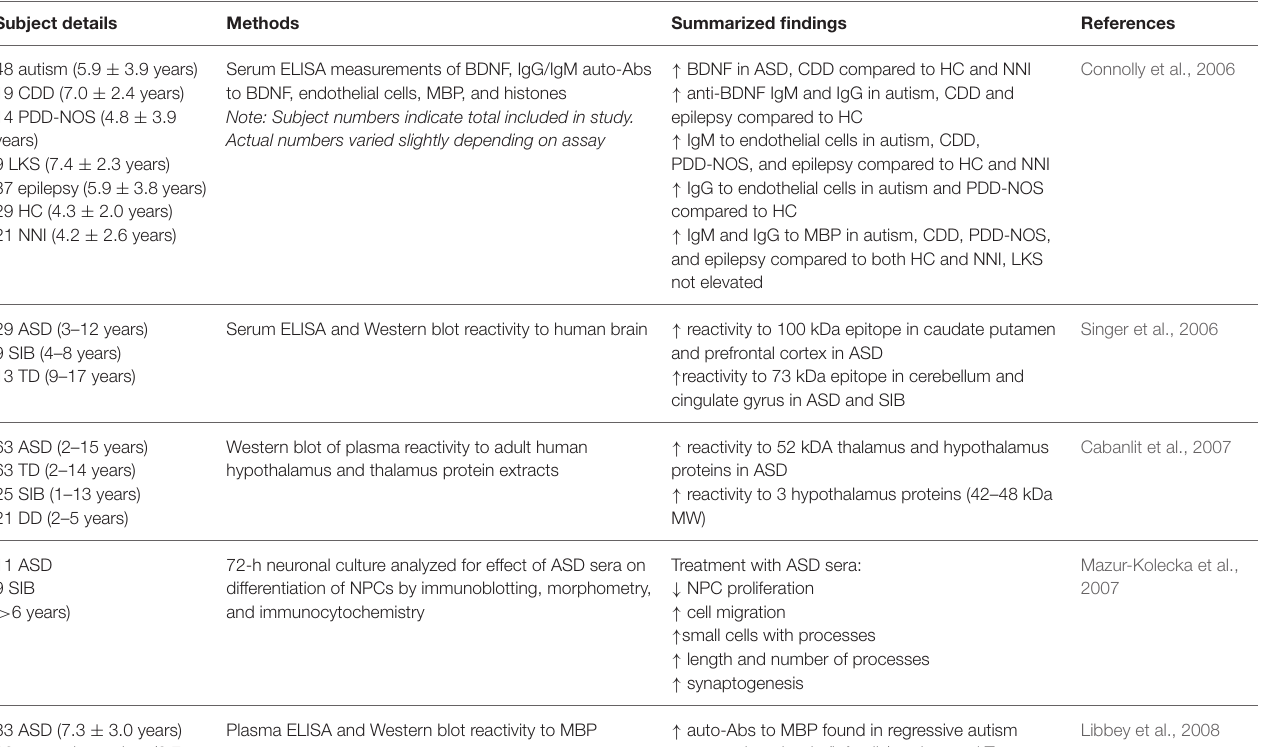
TABLE 4 | Studies identifying presence of autoantibodies in individuals with